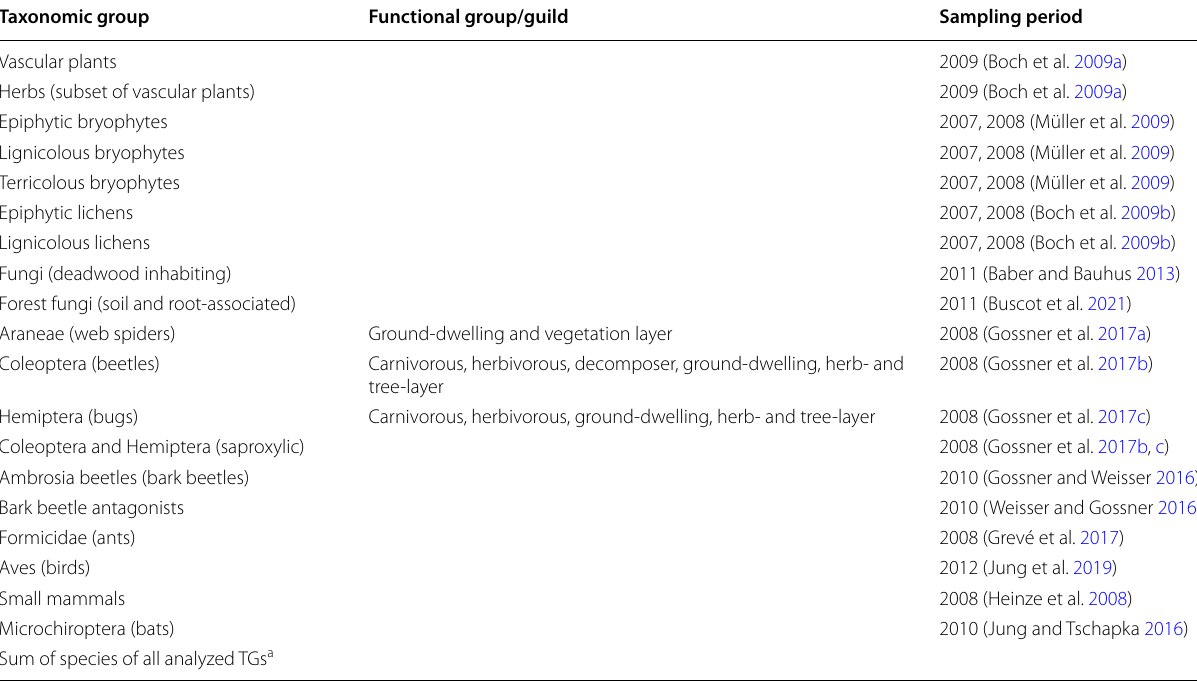
Table 1 Overview of analyzed taxonomic/functional groups and sampling dates, based on data of the German biodiversity exploratories